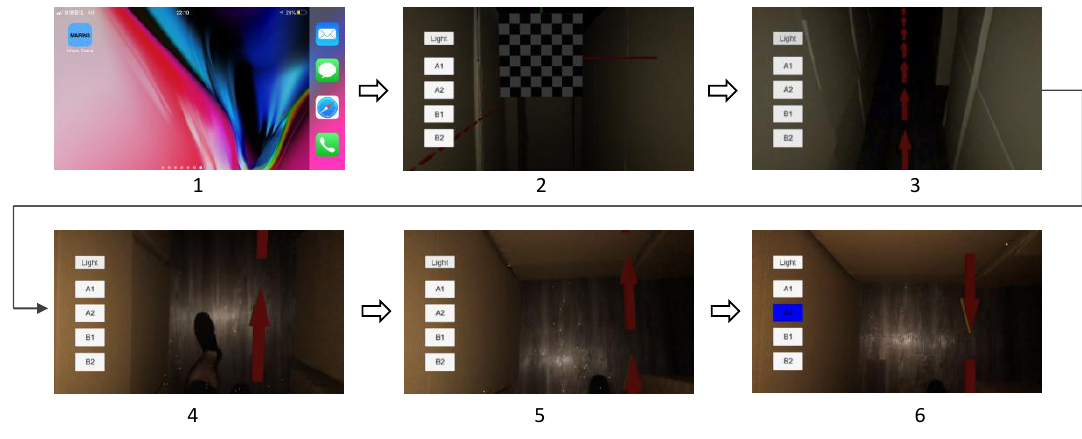
Figure 3. Operational procedures of MARINS.